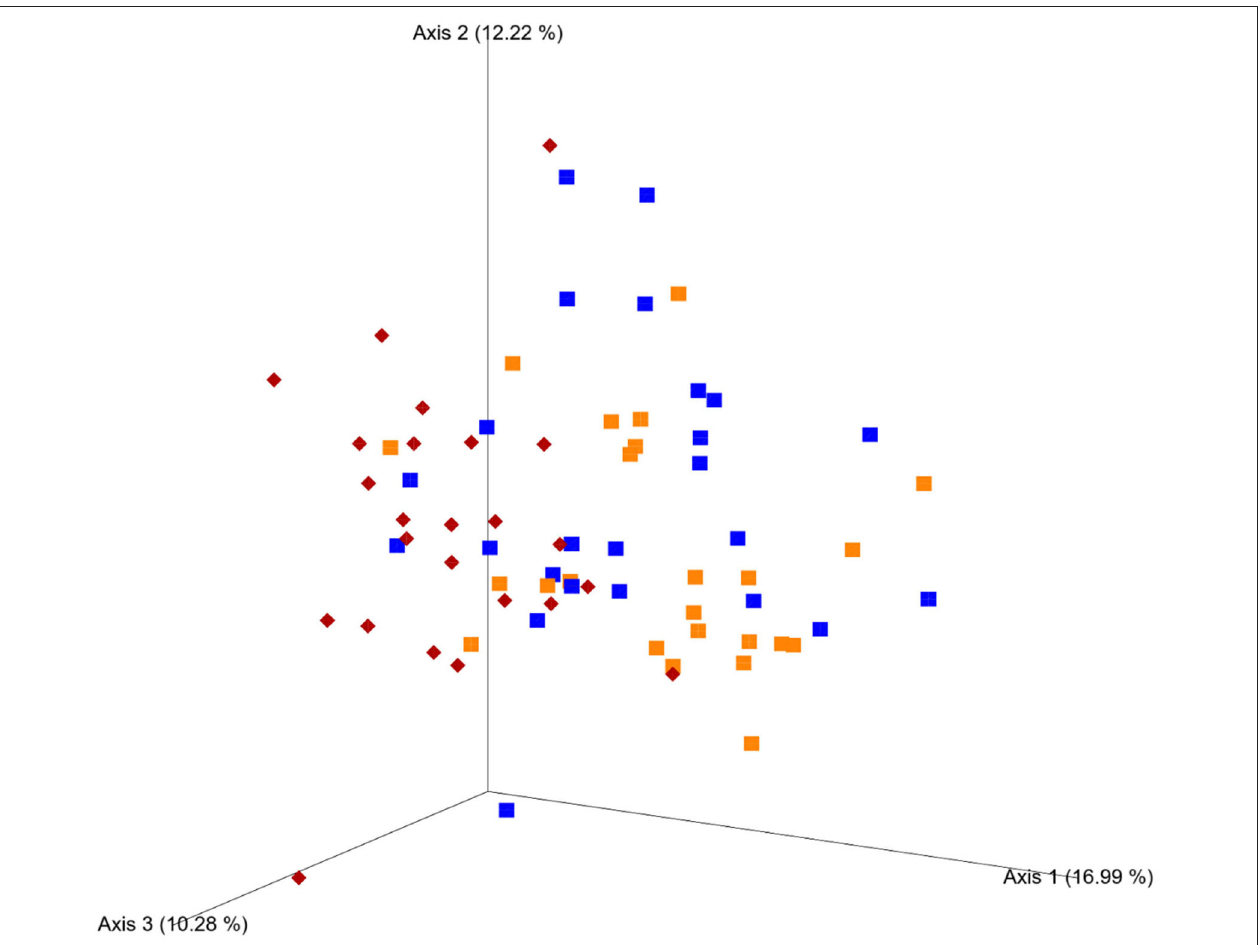
FIGURE 4 | Phylogenetic clustering of fecal microbiota based on principal coordinates analysis (PCoA) plots in regard to the weighted UniFrac distance matrix. Cows fed a 40% concentrate diet (M diet, red) followed by 4 weeks of a 60% concentrate diet (H diet week 1, blue; week 4, orange). Principal components (axis) 1, 2, and 3 indicate the % of variation explained between the